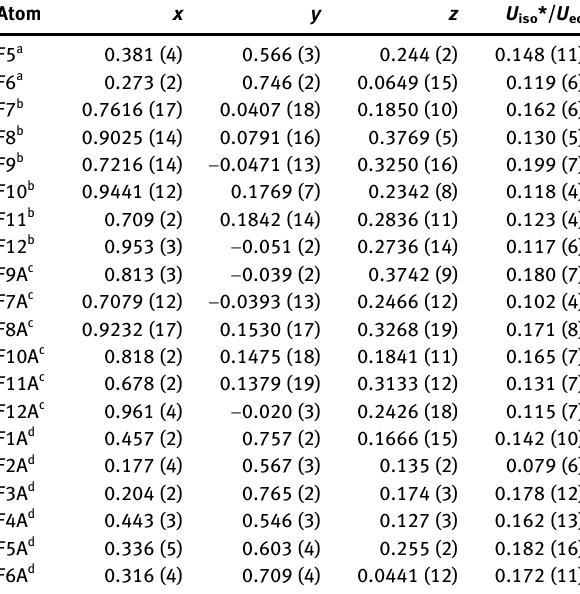
Table  : Fractional atomic coordinates and isotropic or equivalent isotropic displacement parameters (Å 